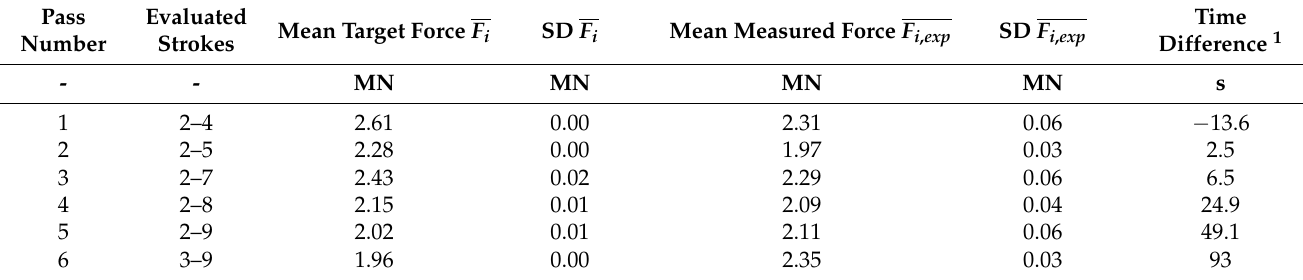
Figure 11. Plot of the expected and measured averaged forces and the measured time delay. Table 6. Overview of the expected and measured averaged forces and their standard